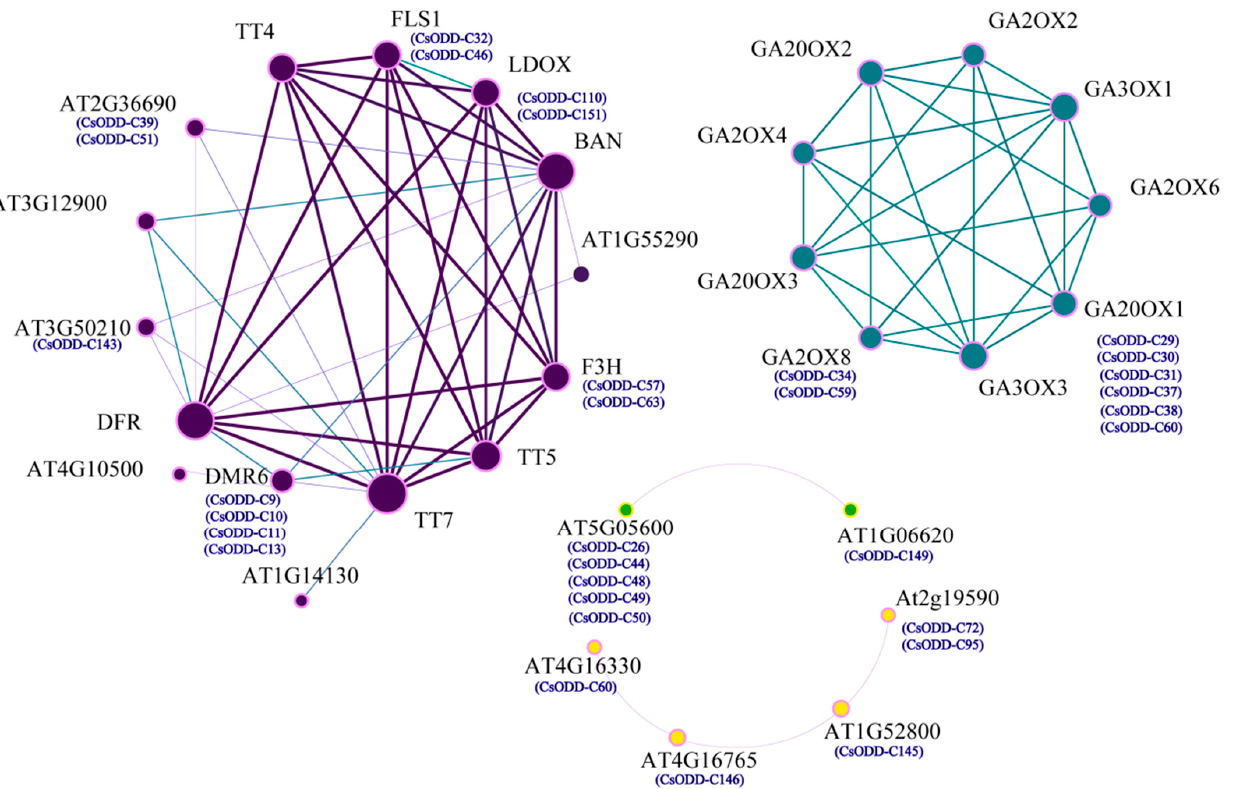
Figure 11. Protein interaction network analysis for the candidate Cs2ODD − Cs involved in response to MeJA, PEG, and NaCl stresses. The online tool STRING was used to predict the network.